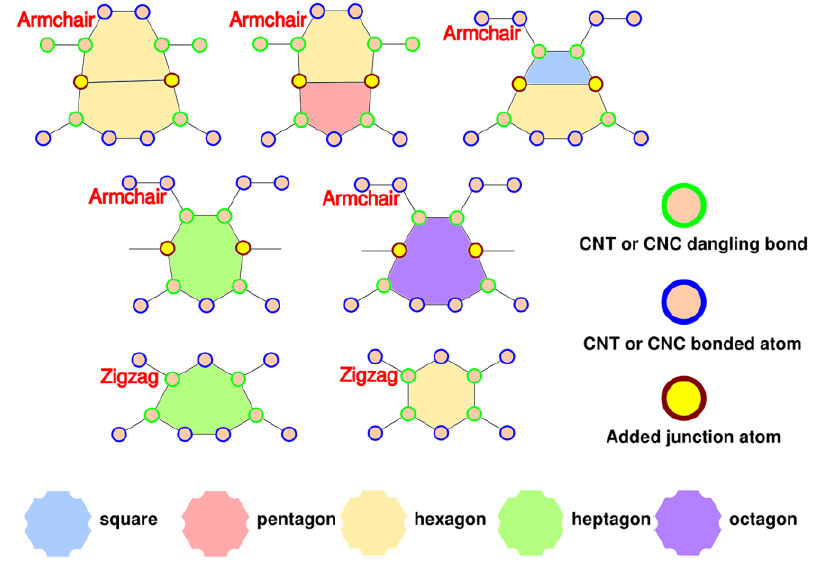
Figure 6. The possible types of junction zones and the rings formed inside the junction.